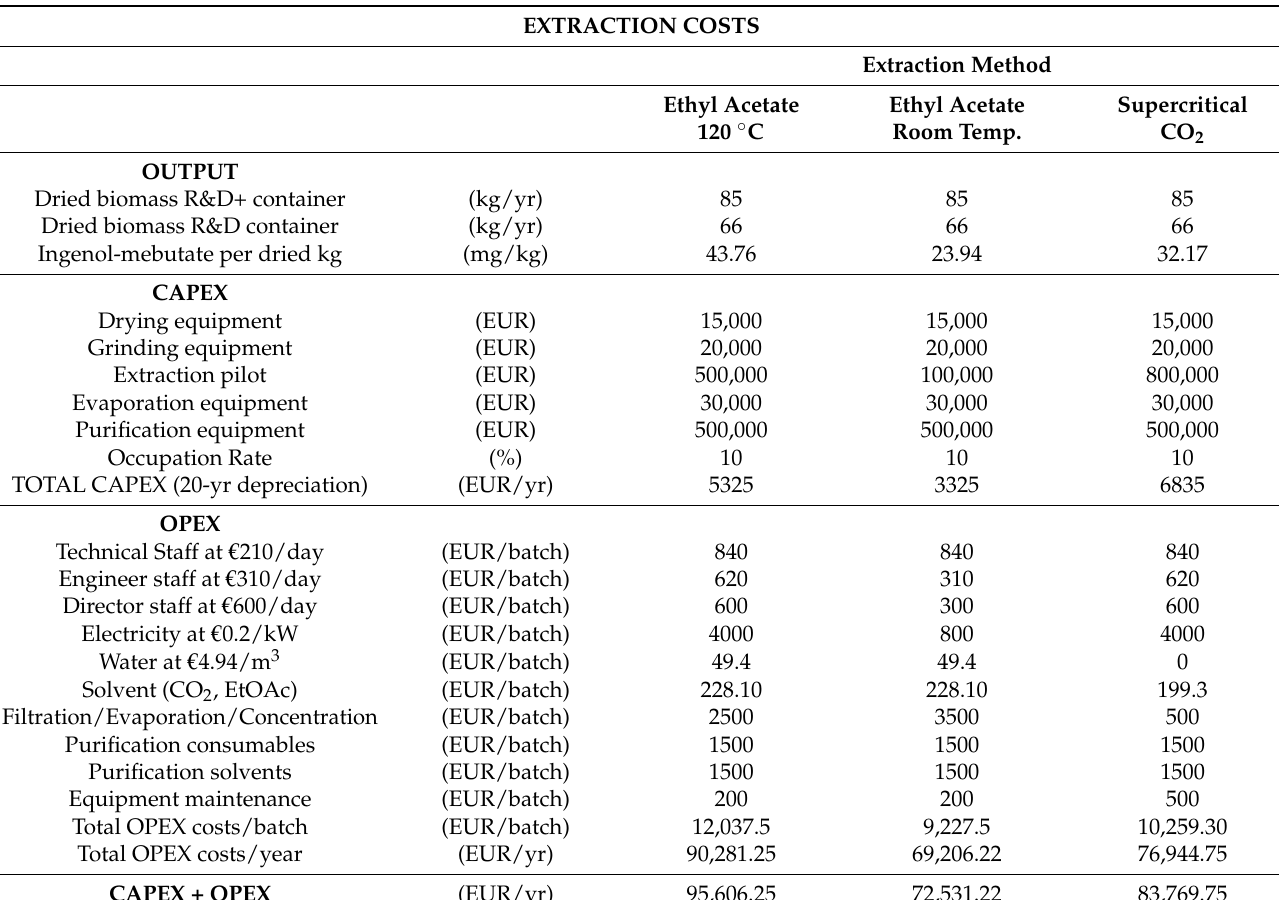
Table 5. Extraction costs of ingenol-mebutate from Euphorbia peplus following three extraction to the biomass generated in the container R&D and R&D+ under 500 PAR. Extraction yields